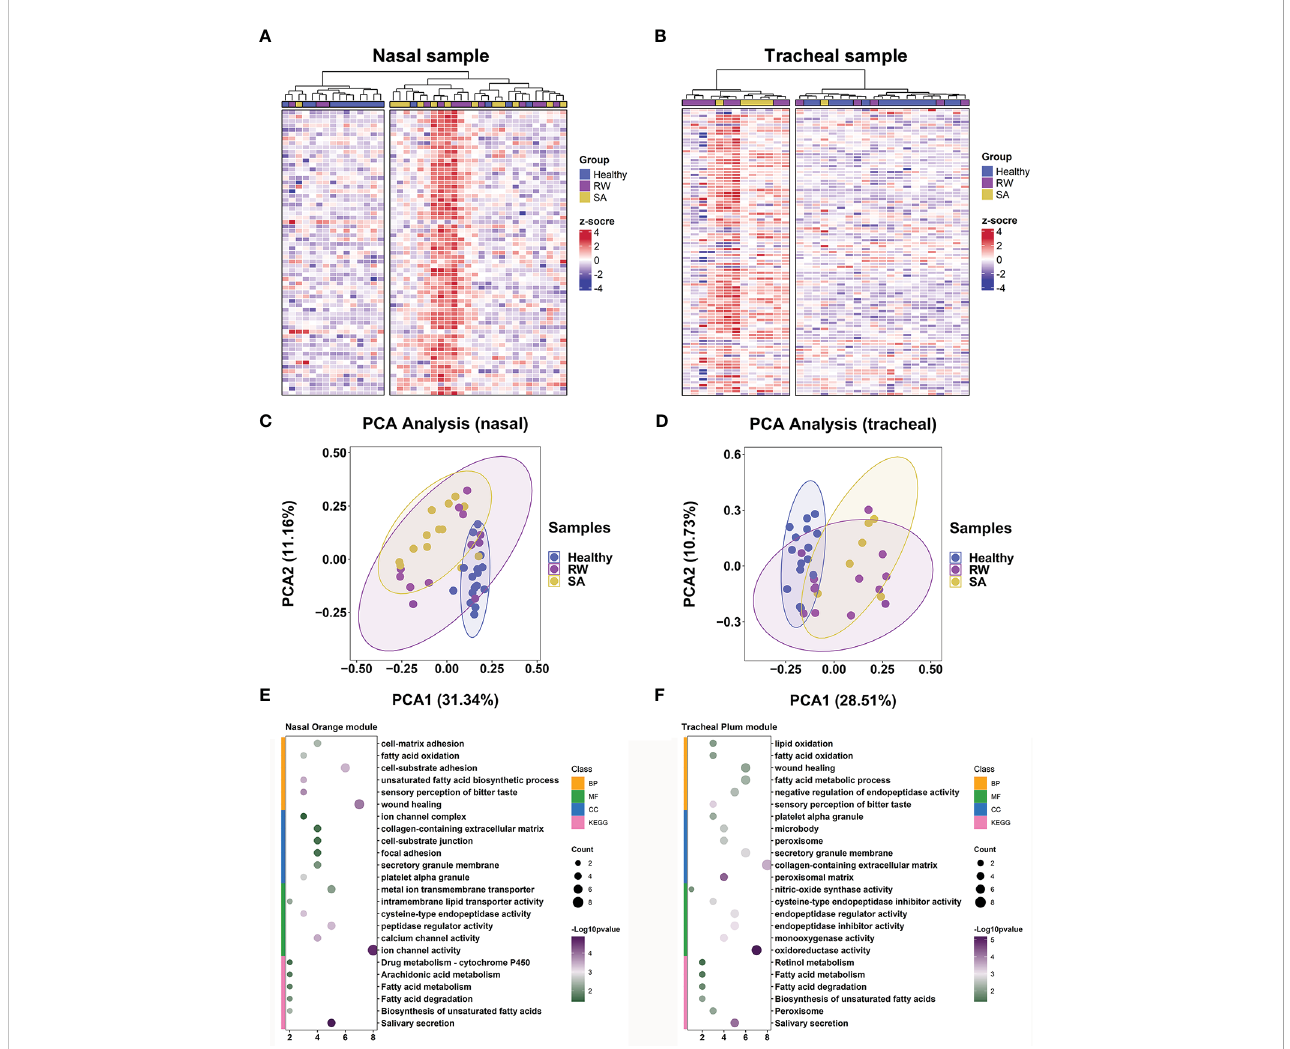
FIGURE 6 Key consensus module gene signatures can distinguish RW and SA from controls across both upper and lower airway samples. Heatmaps of expression patterns of 66 genes in nasal orange consensus module across all nasal samples (A) and 98 genes in tracheal plum consensus module across all tracheal samples (B) , where genes and samples were ranked using hierarchical clustering. PCA across all nasal samples based on 66 genes in nasal orange module (C) and across all tracheal samples based on 98 genes in tracheal plum module (D) . Dot plot showing enriched GO terms (BP, CC, and MF) and KEGG pathways for nasal orange module (E) and tracheal plum module (F) , respectively. BP, biological process; CC, cellular component; KEGG, Kyoto Encyclopedia of Genes and Genomes; MF, molecular function; PCA, principal component analysis; RW, recurrent wheezing; SA, school-age